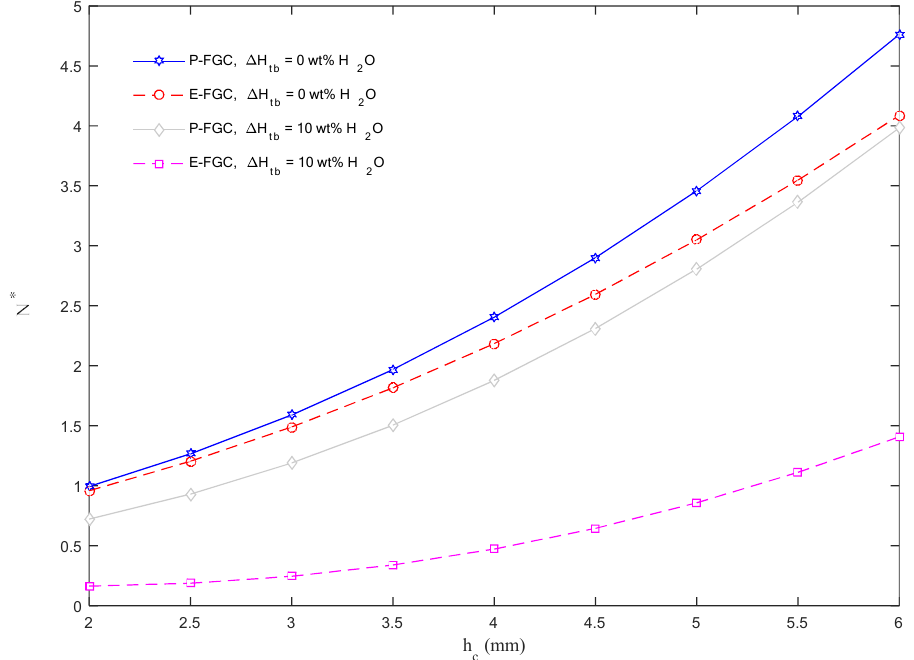
Figure 6. Dimensionless critical buckling load versus the core thickness for different moisture variations, based on E&P-FGC models.